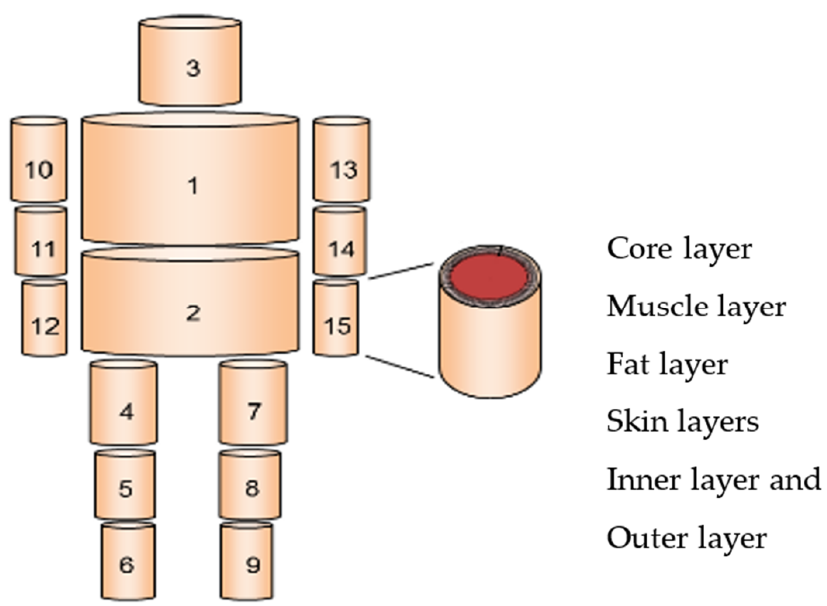
Figure 1. The different segmentation of 65 nodes model.